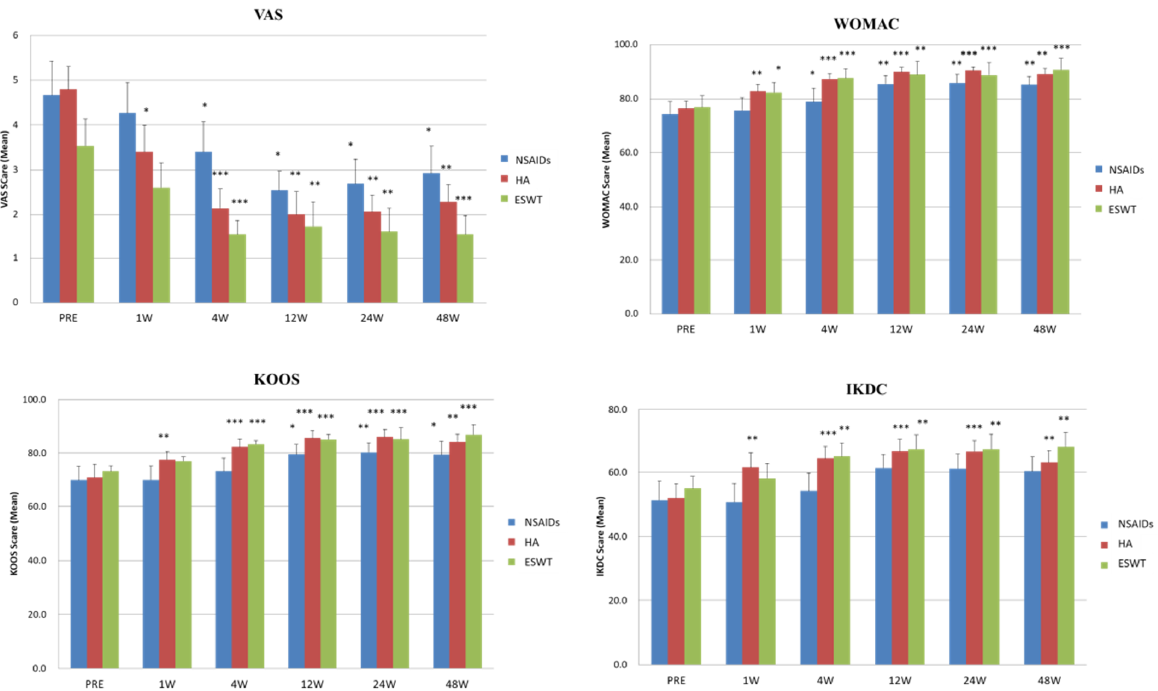
Figure 3. The trends of pain and functional scores improvement during our treatment course at 1, 4, 12, 24, and 48 week (W). * p -value < 0.05, ** p -value < 0.01, *** p -value < 0.001 as compared with the data before treatment (PRE).